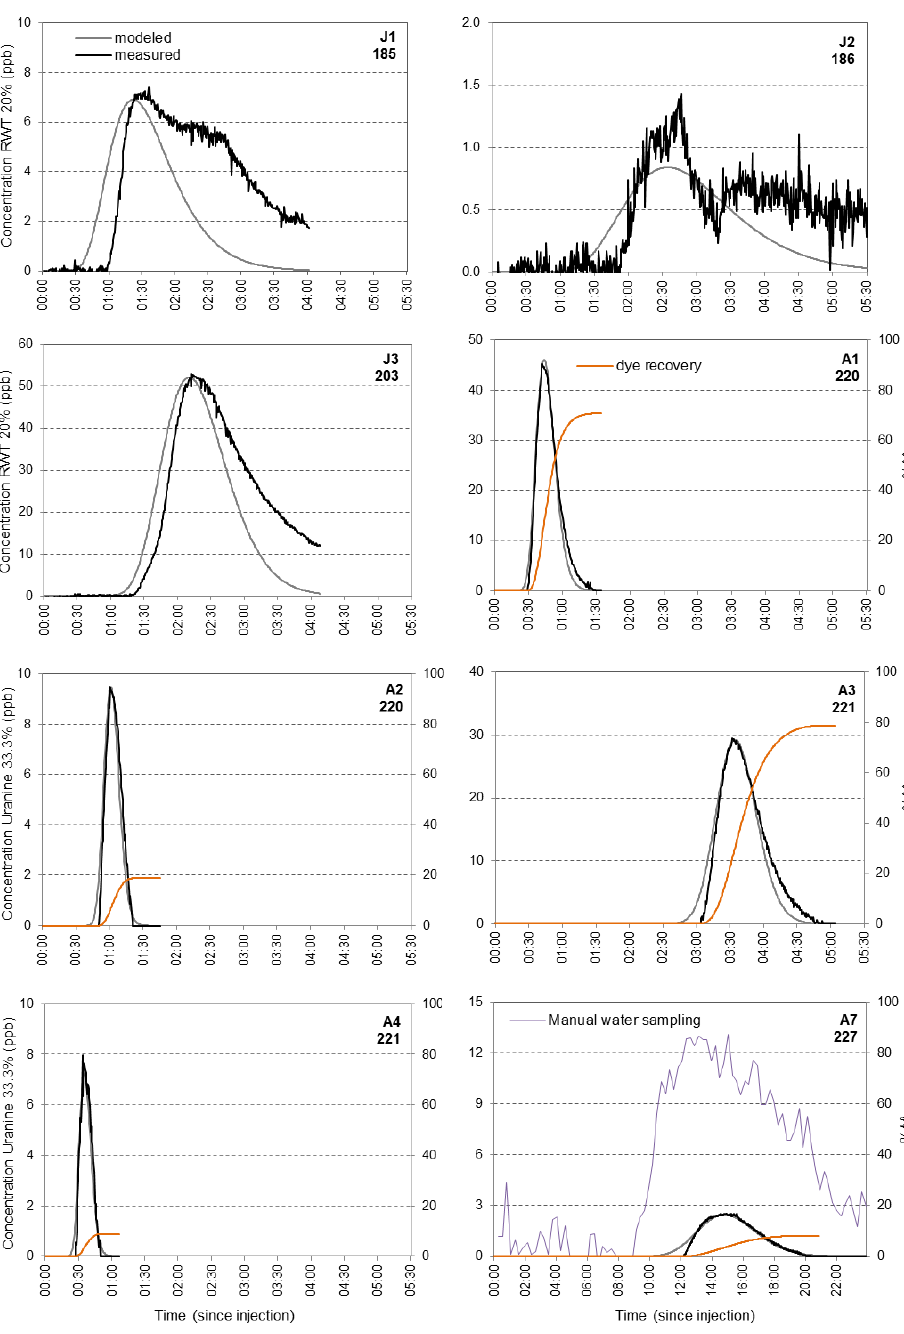
Figure 5. Modelled and measured dye breakthrough curves, including dye recovery for the August experiments. Discharge was not measured during the course of the July experiments, preventing the calculation of dye recovery. Note that the x axis for experiment A7 differs from the others due to the particularly long dye return time, and the y axes are scaled differently for each experiment in order to best illustrate the form of the breakthrough